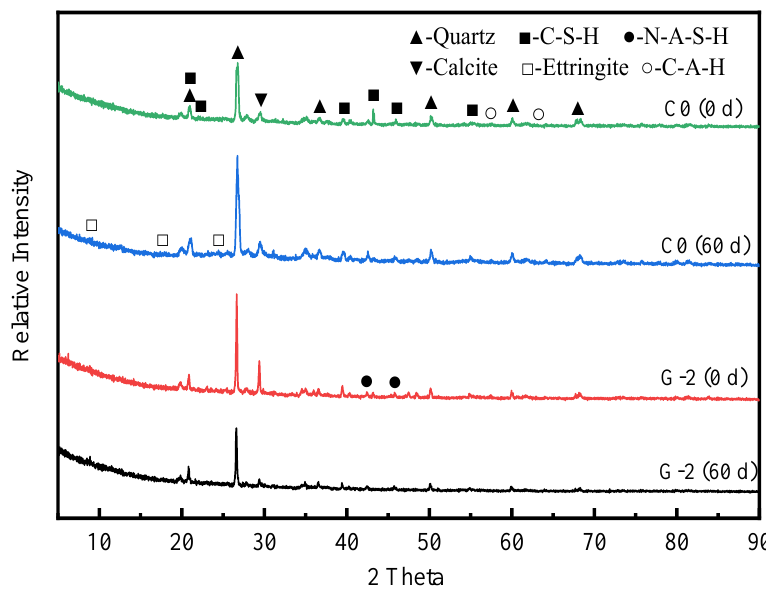
Figure 6. XRD pattern of stabilized soil immersed in sulfate erosion solution.